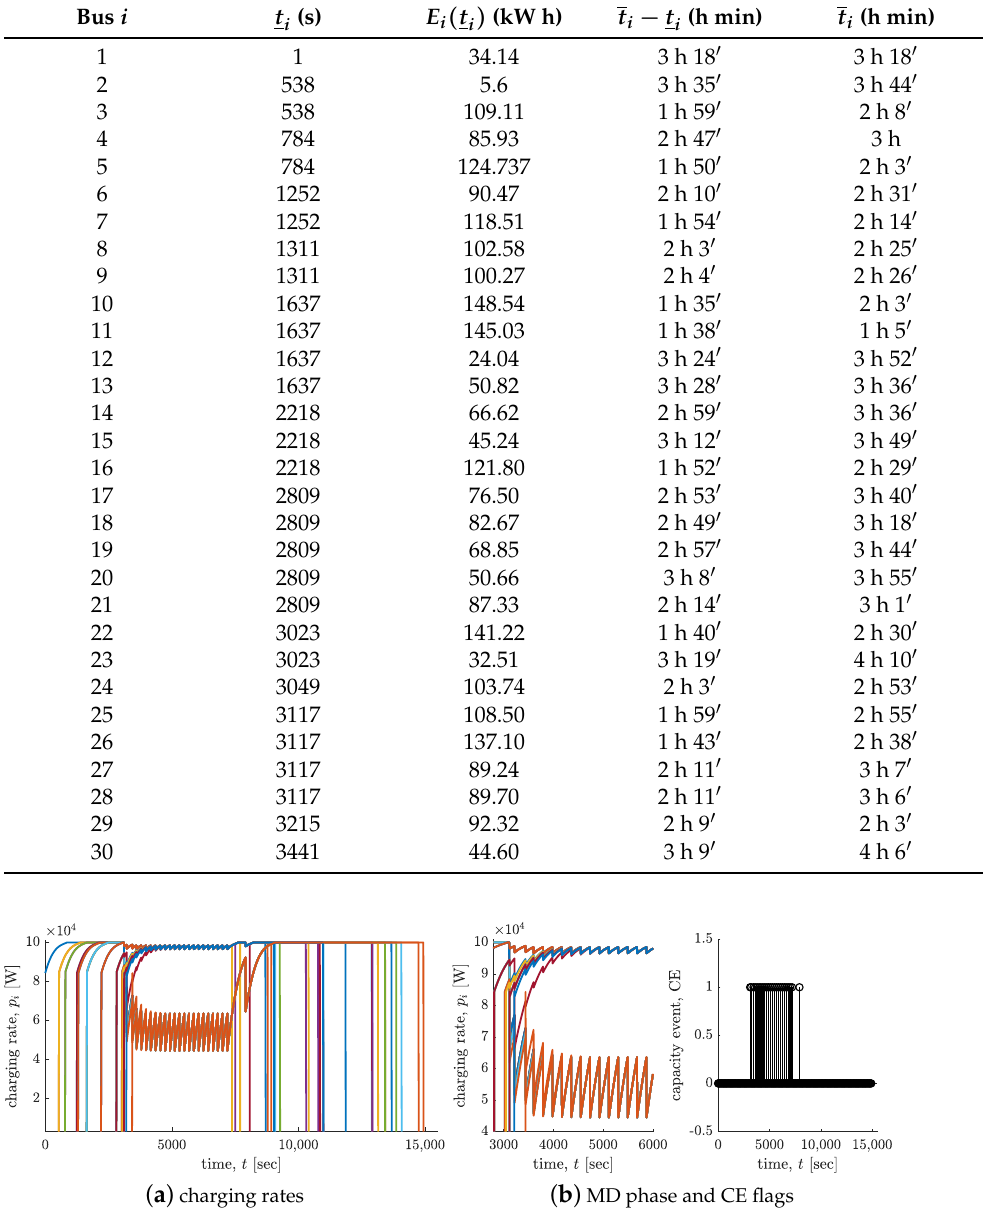
Table 1. Scenario settings and outcomes in terms of charging times.